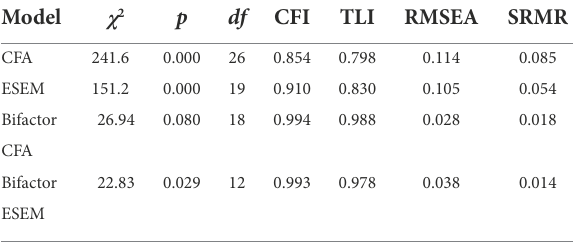
TABLE 1 Model fit indices for four measurement models of the L2 grit.